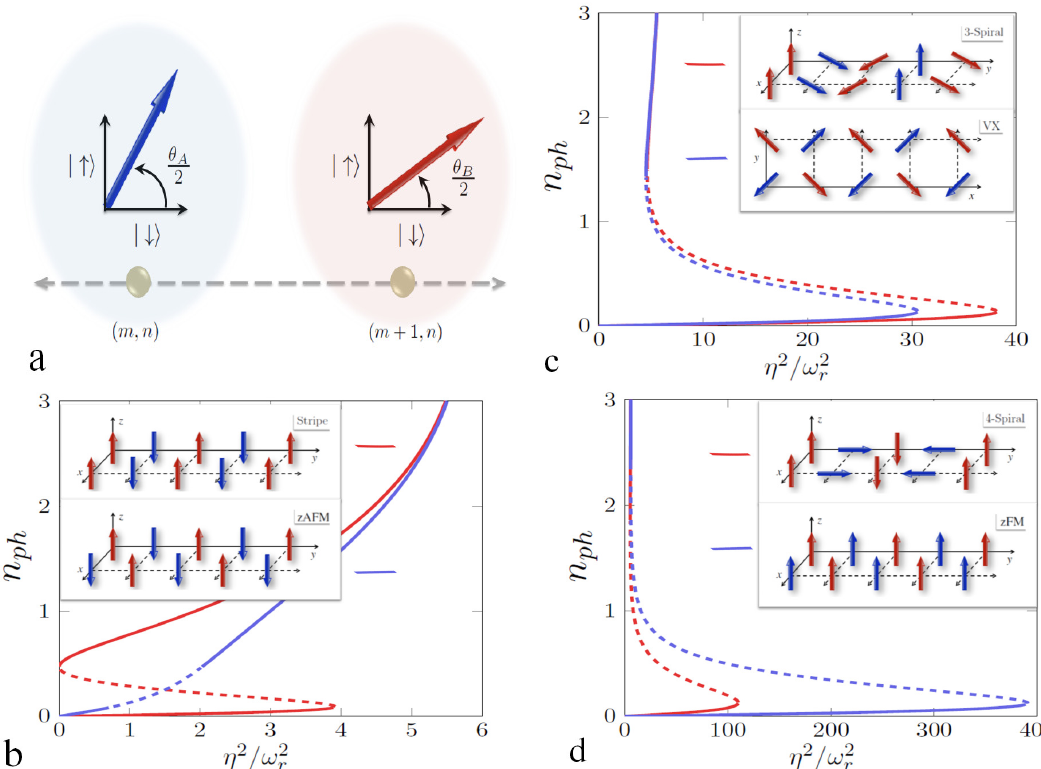
Figure 9. ( a ) The spin vectors in internal spin spaces of two neighboring sites; ( b – d ) Cavity spectrum for different phases in the MI region for different non-abelian flux insertions. The SOC strength for all the phases are ( α , β ) / π = (0.01,0.01) zFM; (0.2, 0.2) 4-Spiral; (0.3, 0.3) 3-Spiral; (0.5, 0.5) Stripe; (0.34, 0.34) VX. Note the turning points are highly dependent upon the phases. The dotted part shows the unstable region of the spectrum. The red and blue legends correspond to the magnetic order, shown in boxes. From [34]. (Reprinted figures with permission from Padhi, B.; Ghosh, S. Phys. Rev. A 2014, 90, 023627. Copyright (2014) by the American Physical Society.